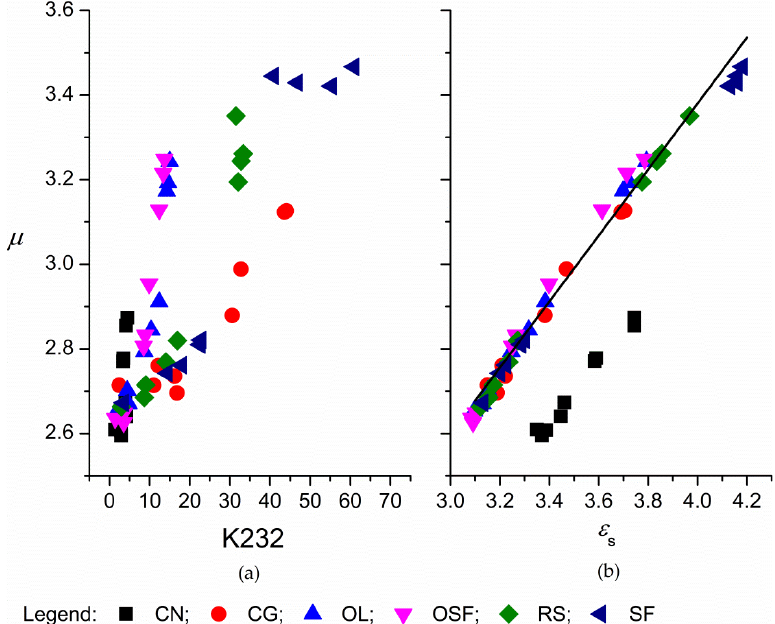
Figure 5. Dependence of the effective dipole moment, µ , on the on the sum of the specific absorption coefficients K232 ( a ) and the dielectric constant, ε s ( b ) for the edible oils thermally treated at 180 °C. CN, coconut oil; CG, corn-germ oil; OL, olive oil; RS, rapeseed oil; SF, sunflower oil; and OSF, high oleic acid sunflower.